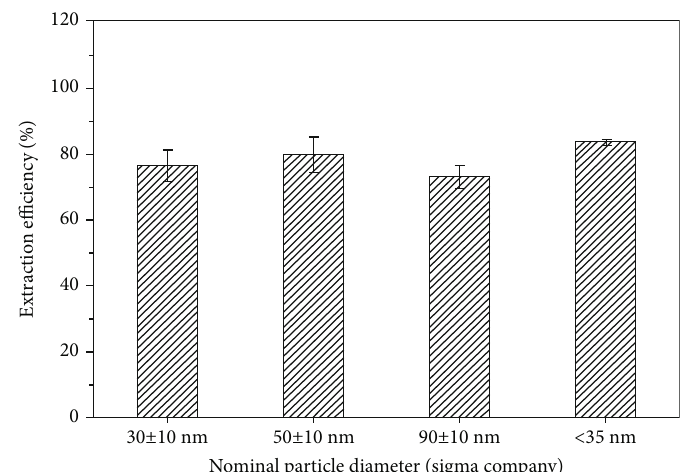
Figure 3: Recoveries of ZnONPs with di ff erent particle diameters in water samples ( n = 3